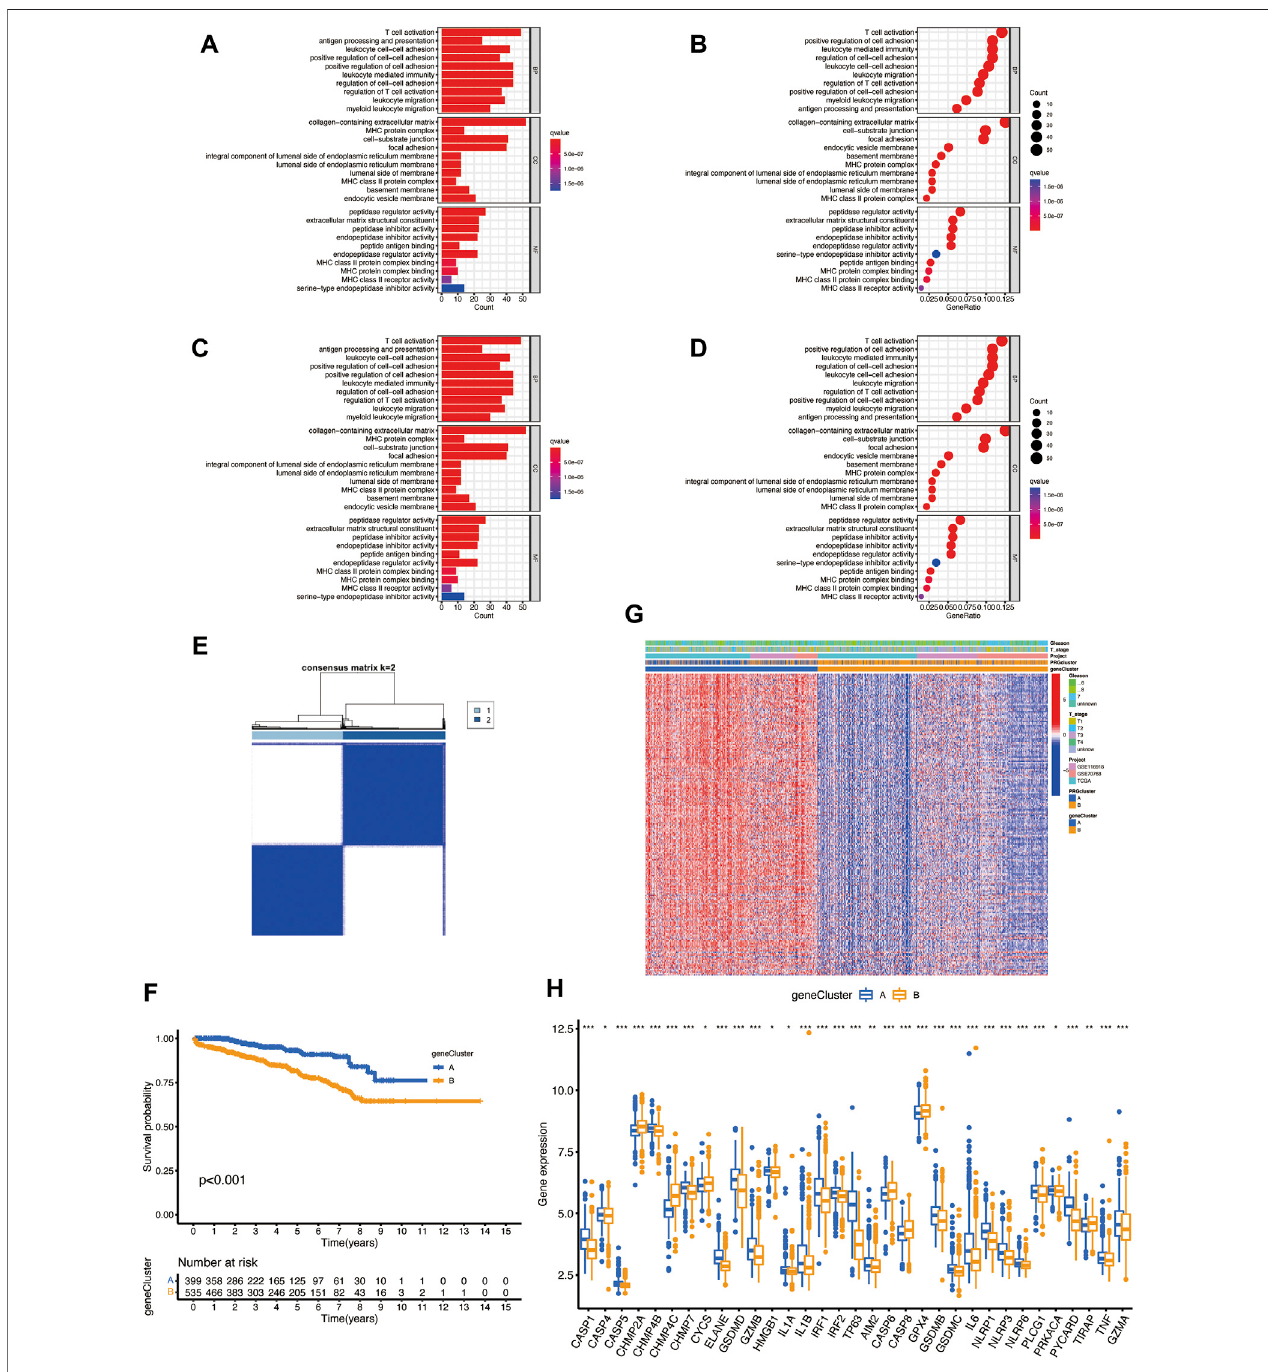
FIGURE 3 | (A – D) ThepossiblepathwayassociatedwithDEGsoftwosubtypesbyKEGGandGOanalysis. (E) Consensusclusteringanalysisdividespatientsintotwogene clusters. (F) Prognosisoftwoclusters. (G) Theheatmapshowstherelationship betweenclinicalfeaturesandtwoclusters. (H) DifferentialexpressionofPRGsbetweentwoclusters.